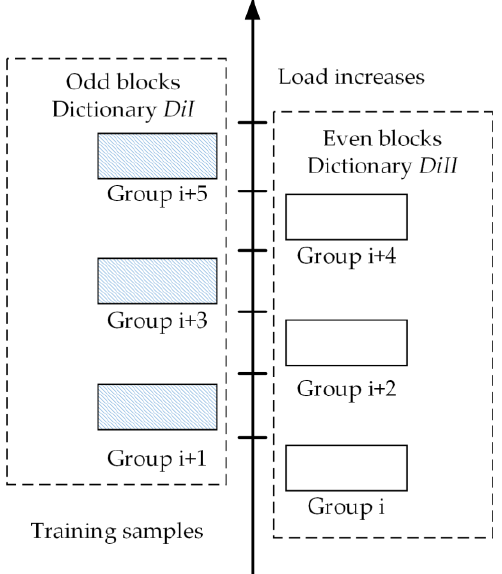
Figure 8. Dictionary composition of interleaved block groupings.